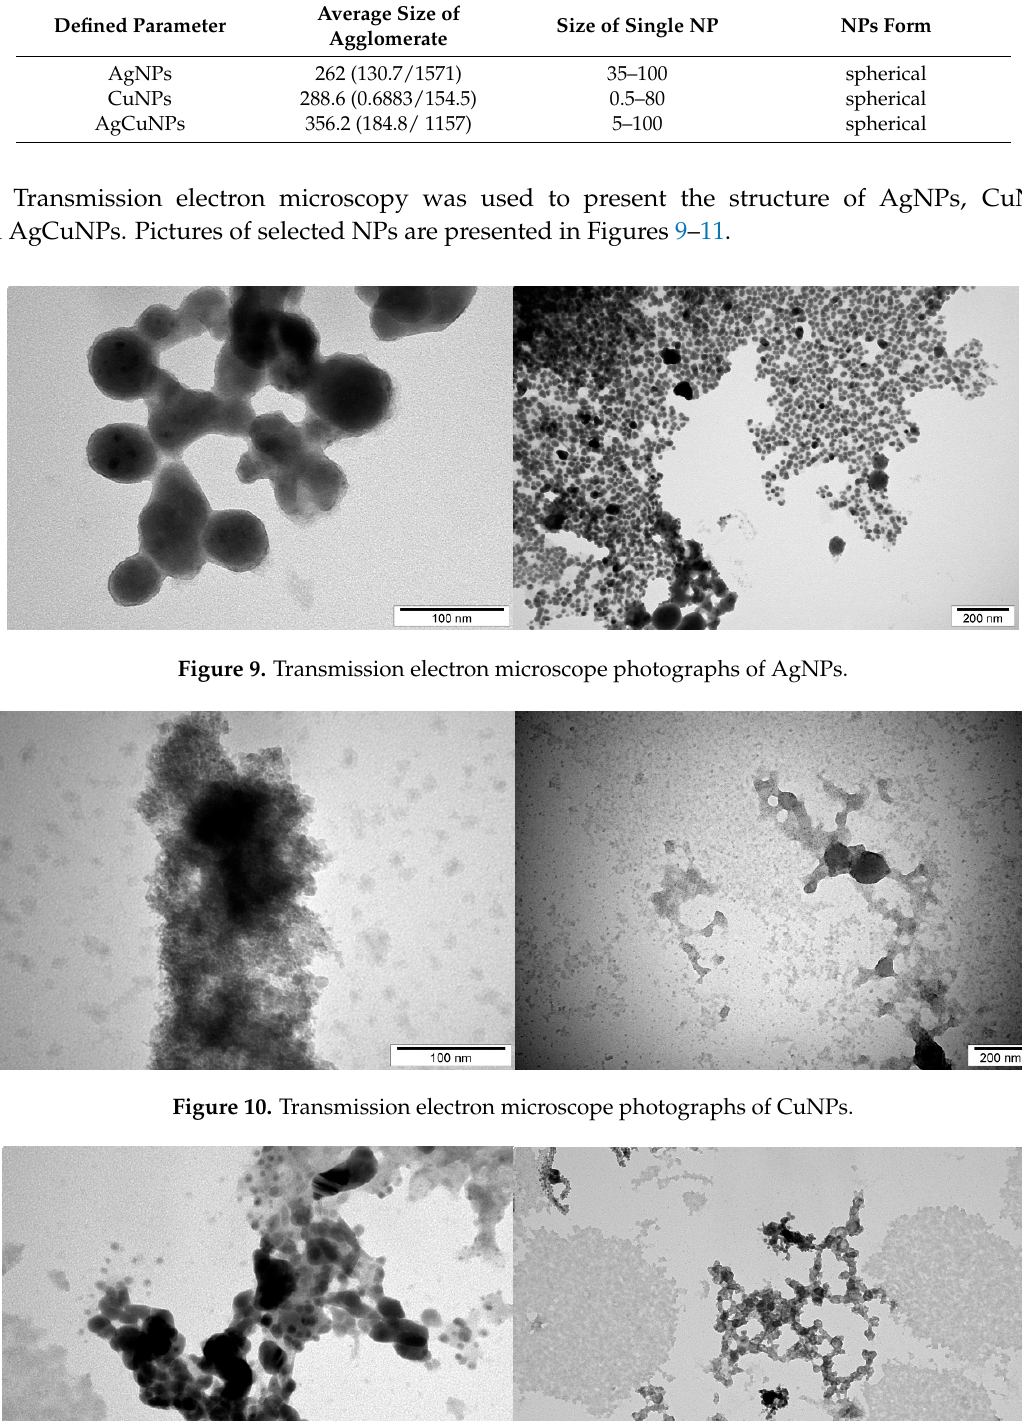
Table 2. Distribution of size and structure of selected NPs.